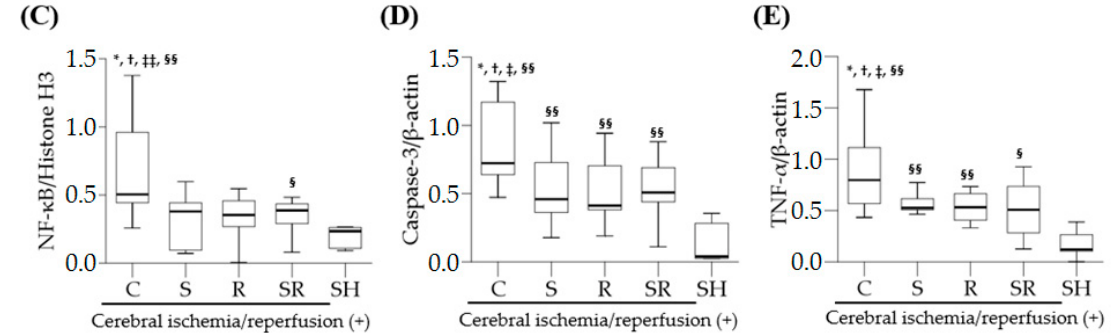
Figure 3. ( A ) Representative Western blot analysis of toll-like receptor 4 (TLR-4), nuclear factor kappa B (NF- κ B), caspase-3, and tumor necrosis factor-alpha (TNF- α ) one day after transient